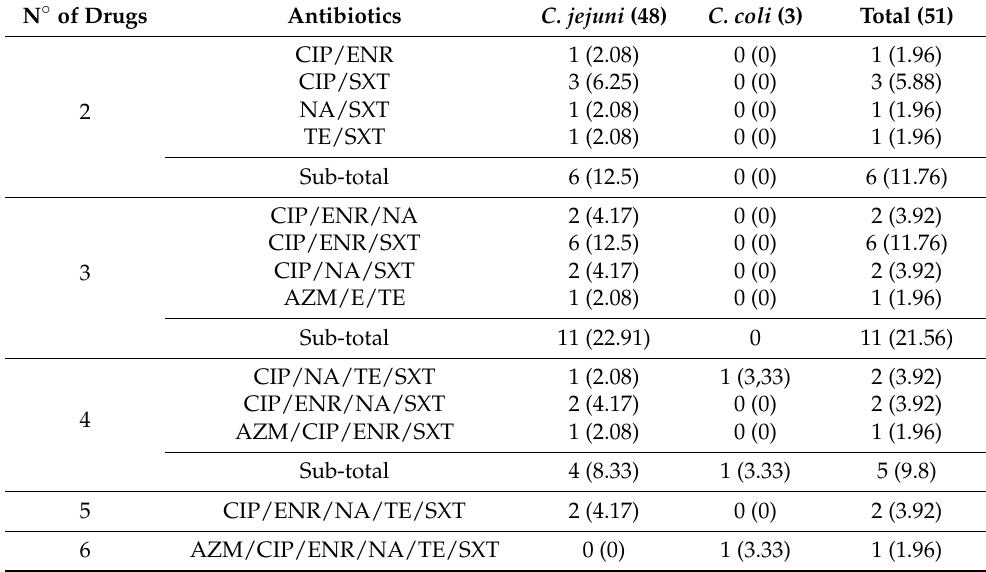
Table 9. Multidrug resistance found in C. jejuni and C. coli strains detected from wild birds. N ◦ of Drugs